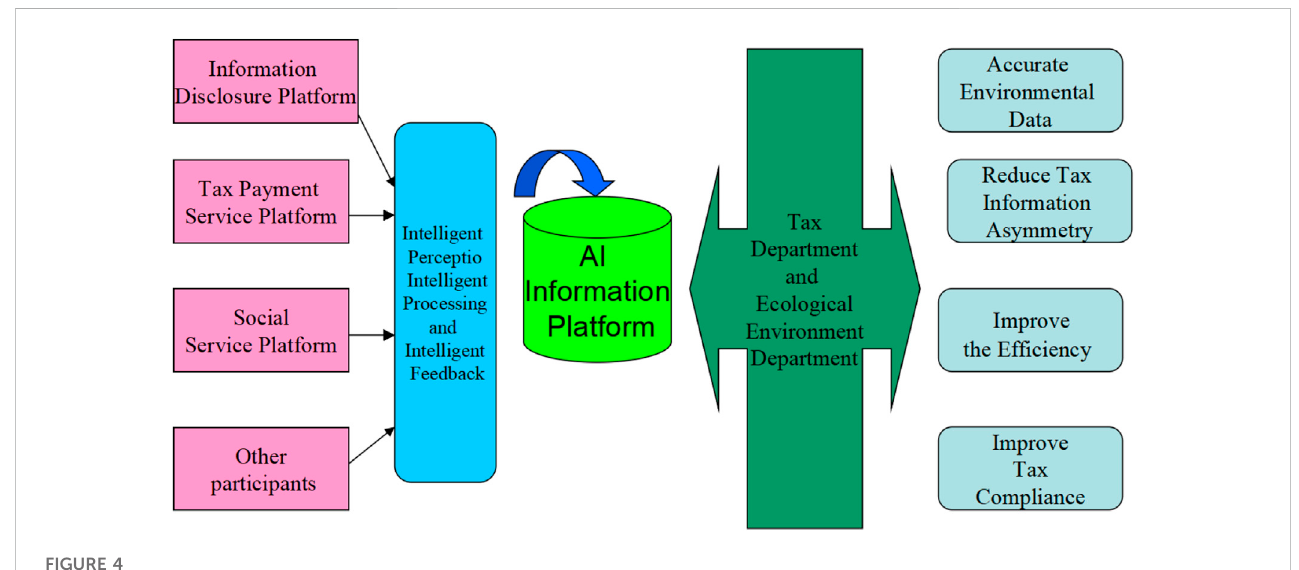
FIGURE 4 AI and environmental protection tax